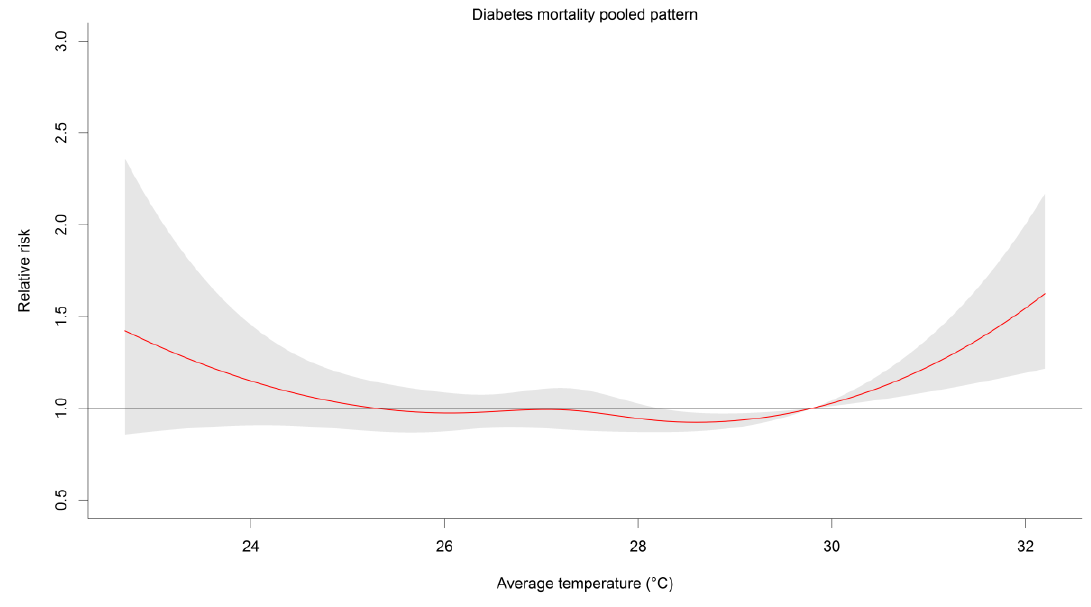
Figure 2. Pooled pattern of the risk curves of four tropical cities. Red solid line is the pooled pattern, while the gray areas are the 95% confidence interval.